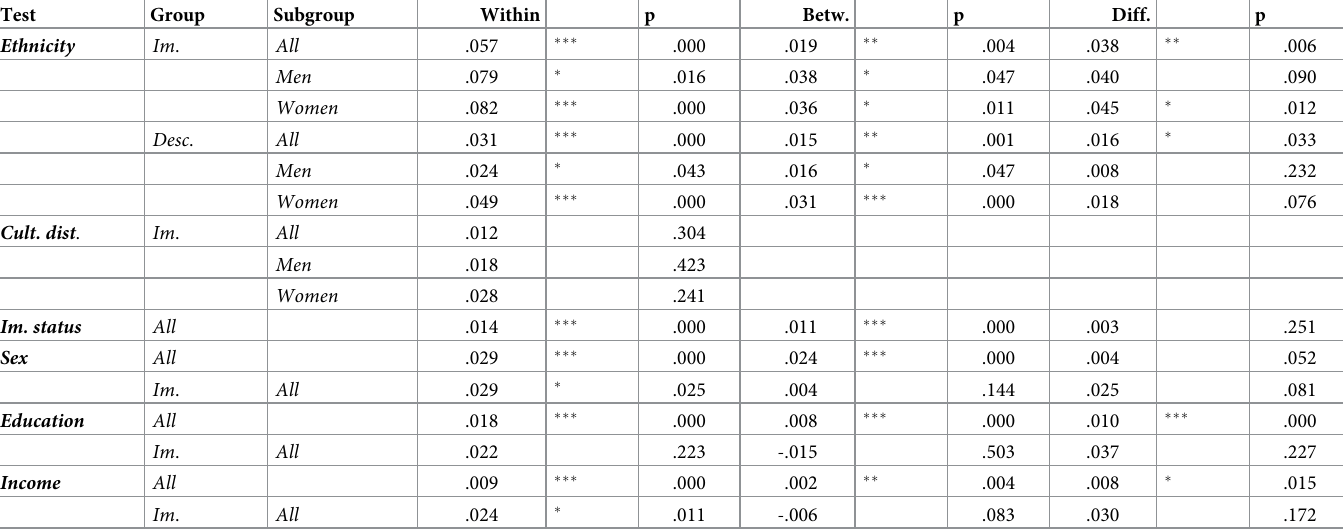
Table 1. Summary of results. Correlation coefficients, significance levels and p-values (from the QAP, without adjustment for multiple testing in subgroups) for all 16 sep- arate